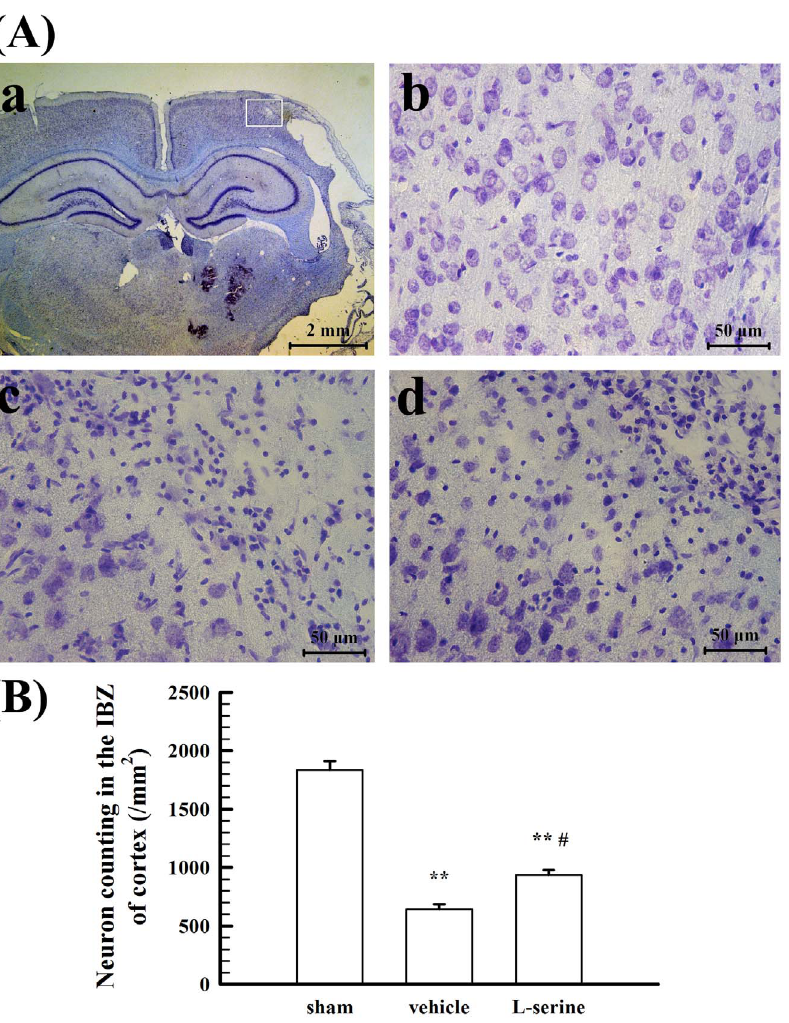
Figure 2. Nissl staining and cell counting of the IBZ of rat cortices 35 days after pMCAO. (A) Representative examples of Nissl staining: a, quadrate box is the area of neurons counted; b, sham-operated group; c, vehicle group; d, L-serine (168 mg/kg) treated group. (B) Mean values of neurons counted for each group (n=5). ** p , 0.01 vs . sham-operated group; # p , 0.05 vs . vehicle group.